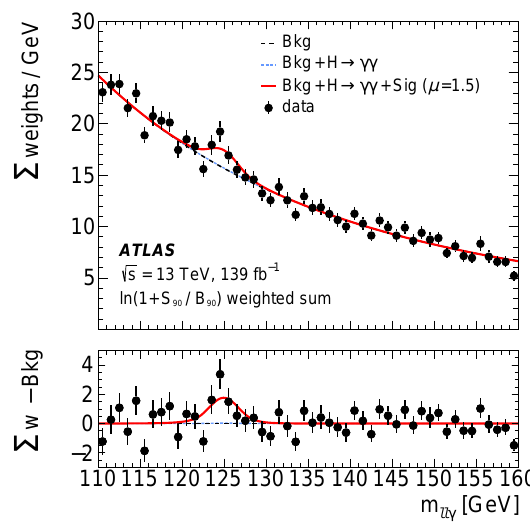
Figure 4: Distribution of m (cid:96)(cid:96)γ , where events from different analysis categories are weighted depending on their signal-to-noise ratio [ 21 ]